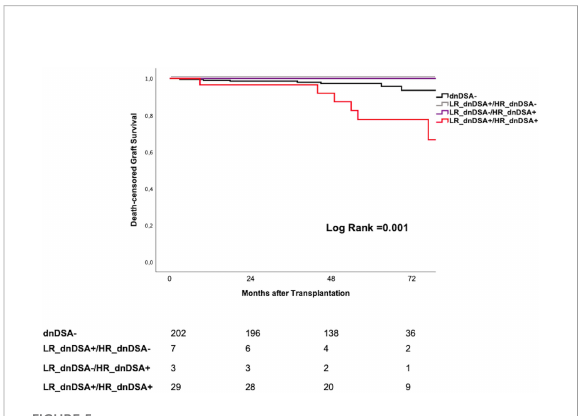
FIGURE 5 Kaplan Meyer Survival curves for death-censored graft